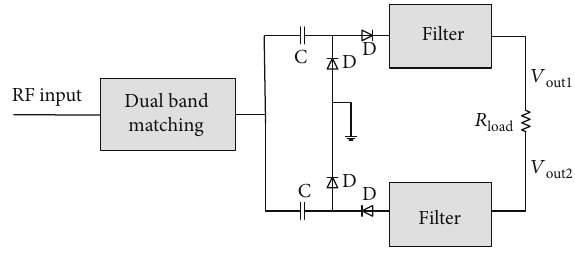
Figure 7: Topology of the proposed dual-band recti fi